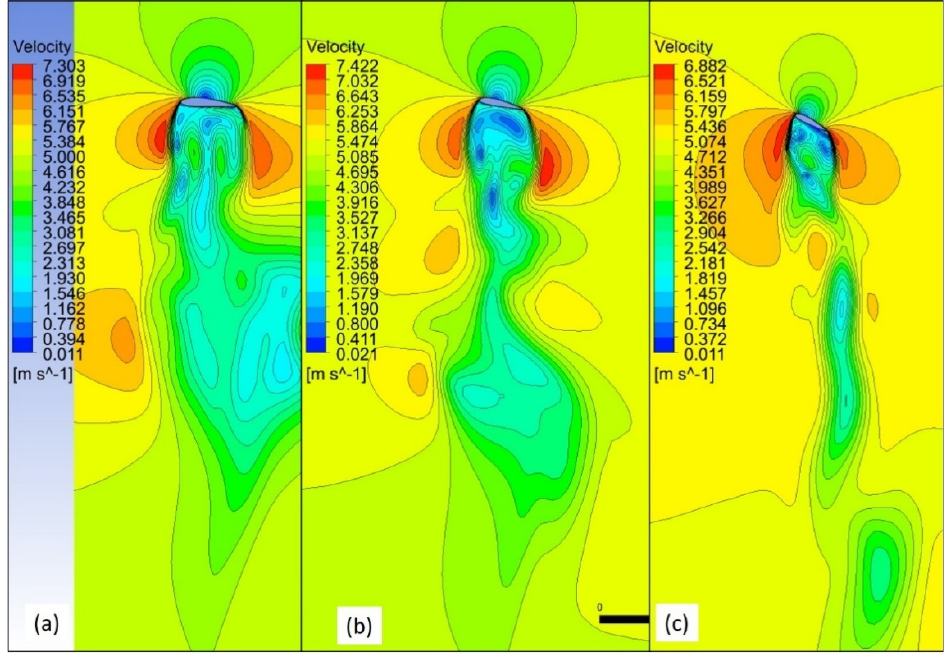
Figure 7. Velocity profile and wake formation at three locations of the span, ( a ) 20% chord from root, ( b ) 50% chord length from rot, ( c ) 90% chord length at 5 m/s (4° angle).